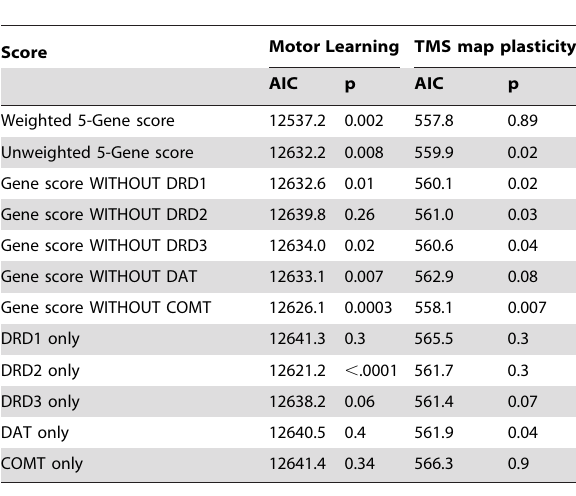
Table 4. Gene scores in relation to learning and